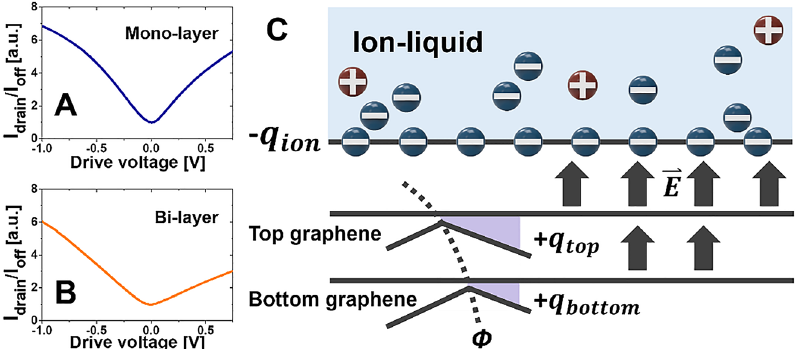
Figure 3: Measured electrical transfer characteristics as a function of applied drive voltage in (A) mono- and (B) bi-layer graphene devices. (C) Schematic representation of the charge distribution and Coulomb potential ø in bi-layer graphene with ion-liquid